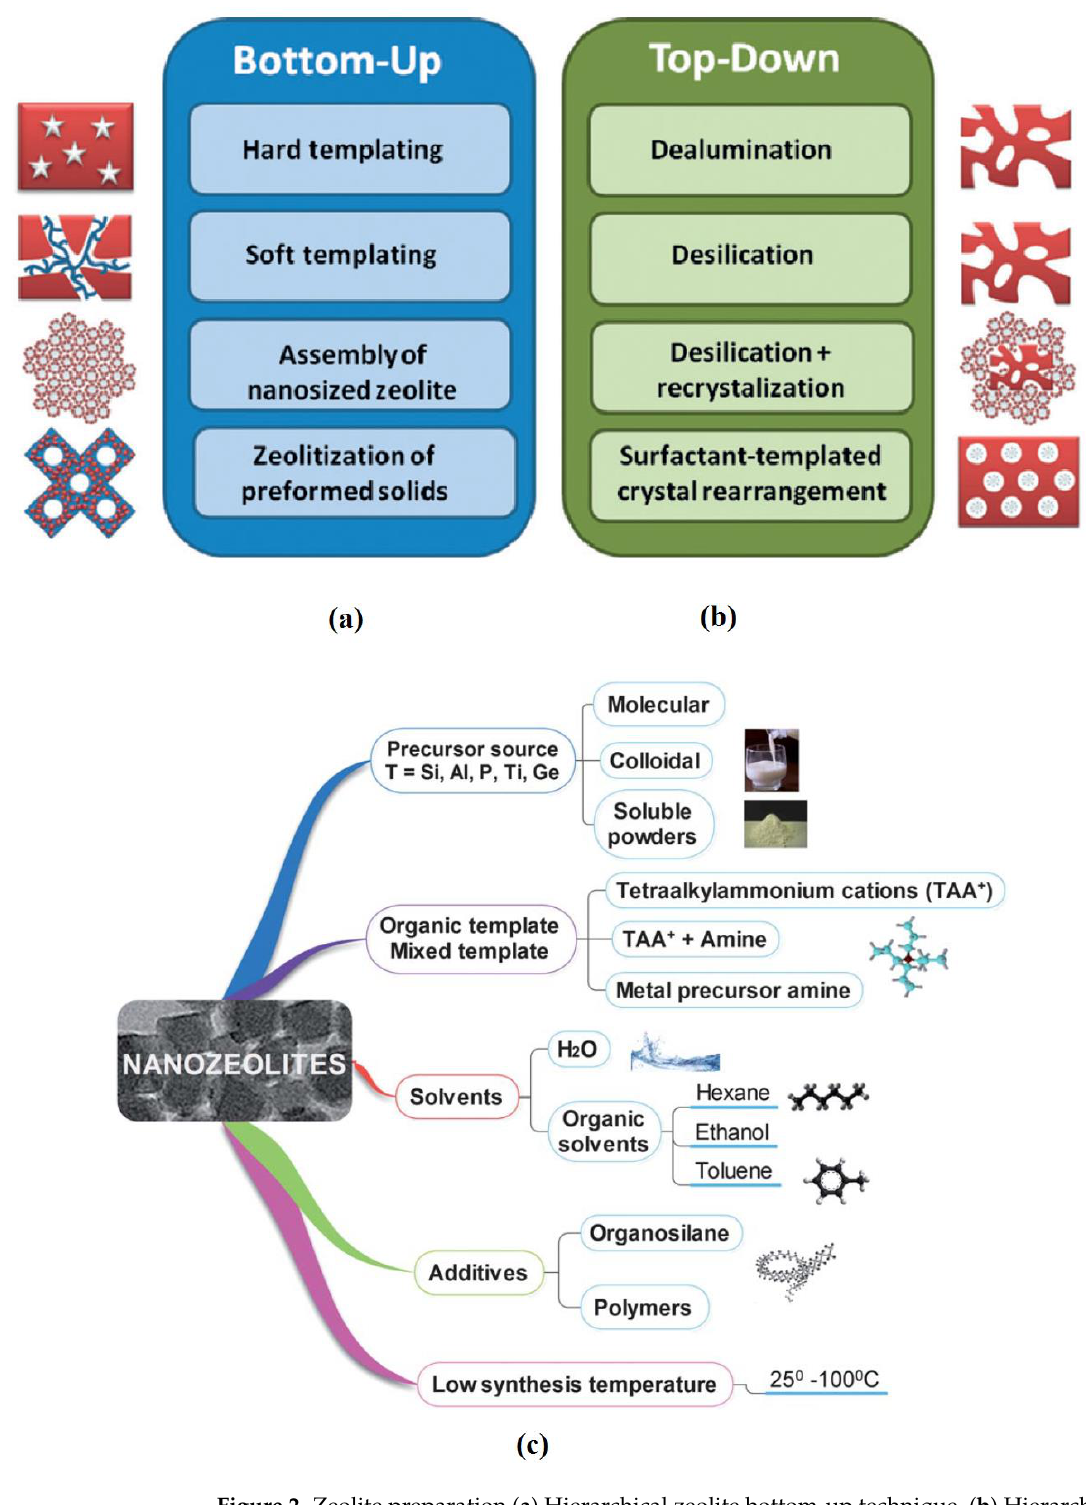
Figure 2. Zeolite preparation ( a ) Hierarchical zeolite bottom-up technique, ( b ) Hierarchical zeolite top-down techniques (Reprinted with permission from [5] 2021) ( c ) Factors that affect the properties of the nano-zeolites. (Reprinted with permission from [6]).